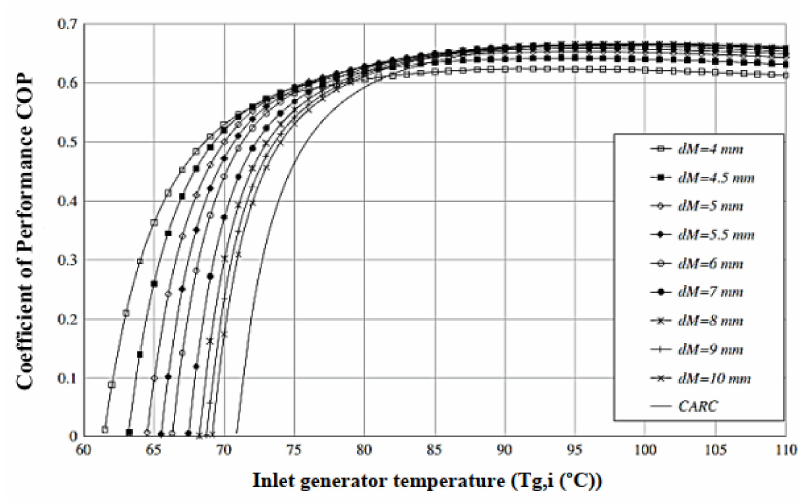
Figure 6. Variation of COP with inlet driving temperature for different mixing tube diameters (dM) of the ejector